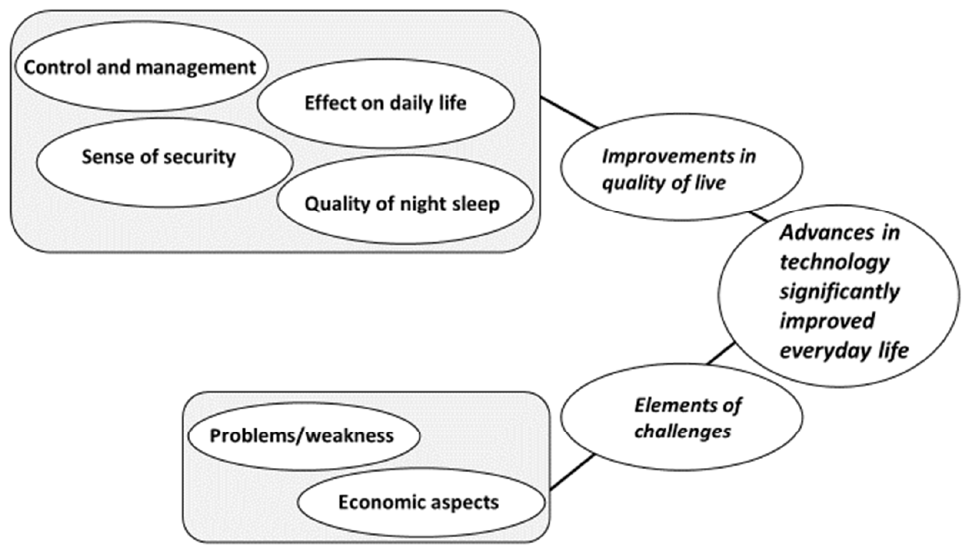
Figure 2. Subcategories, categories, and a main